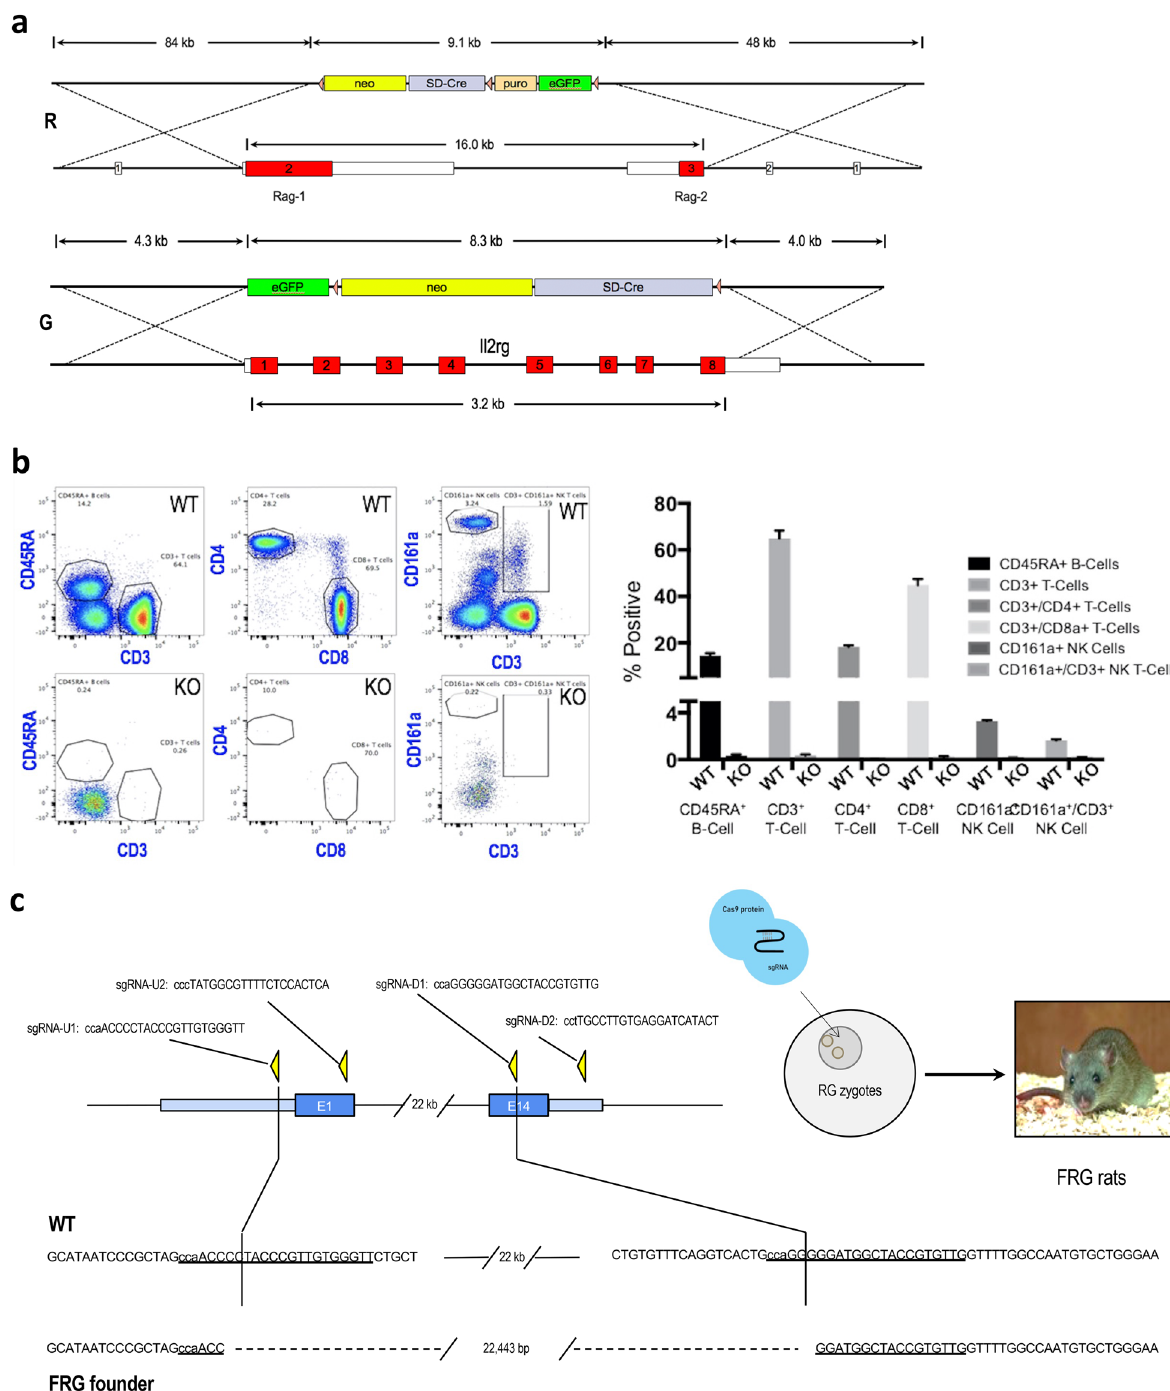
Figure 1. Generation of FRG rats. ( a ) Targeting vector designs for Rag-1/Rag-2 (R) and Il2rg (G). The Rag-1/ Rag-2 vector deletes the entire coding sequence of both genes as well as the Rag-1 3 ′ -UTR, the 5 ′ -UTR and the intergenic region between Rag-1 and Rag-2 . The Il2rg vector deletes the entire coding sequence of Il2rg. ( b ) FACS sorting of PBMC from male RG rats. CD45RA marks B-cells. CD3, CD4 and CD8 mark T-cells. CD161a marks NK cells. RG rats lack virtually all B, T and NK cells. ( c ) FAH knockout and genotyping. sgRNAs were designed to cut in the 5 ′ -UTR, exon 1, exon 14 and the 3 ′ UTR of the rat FAH gene. RNPs containing Cas9 protein and all 4 sgRNAs were electroporated into 1-cell RG embryos. F0 pups were genotyped by TaqMan and candidate FRG founders were confirmed by NGS at the FAH locus. A single F0 male was chosen to establish the FRG